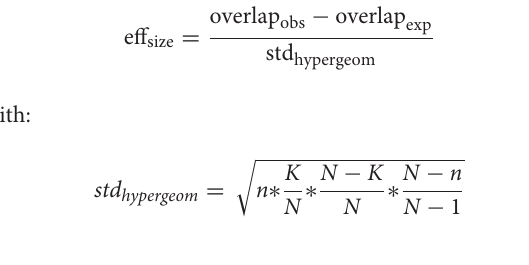
Equation 2: Effect size of the hypergeometric test results